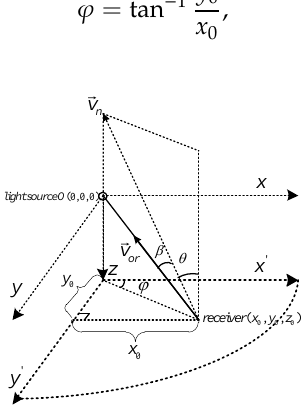
→ V n on the first quadrant of the X–Y